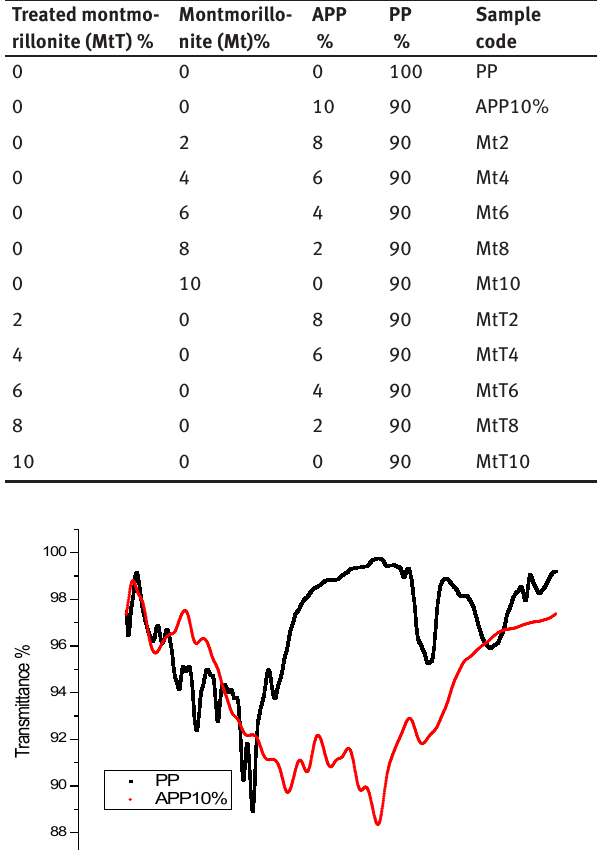
Table 1: The samples codes and preparation conditions of the samples. Treated montmo- rillonite (MtT) %